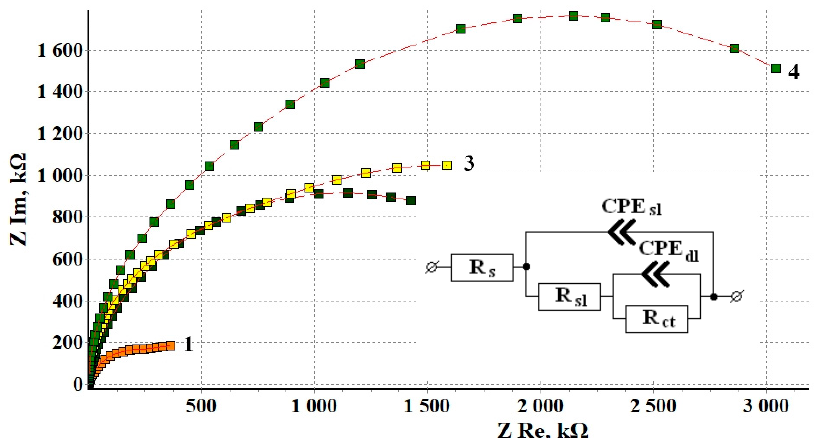
Figure 2. Nyquist plots of copper samples after thermal treatment without a CIN (1) and after CT with the vapors of: BTA (2), ODA (3) and ODA + BTA (4). In this model, the R sl parameter characterizes the resistance that appears in the sur- face layer to the transfer of ions from the near-electrode solution layer to the metal surface (and back). This layer is a thermal air-formed oxide in the “blank experiment” and the